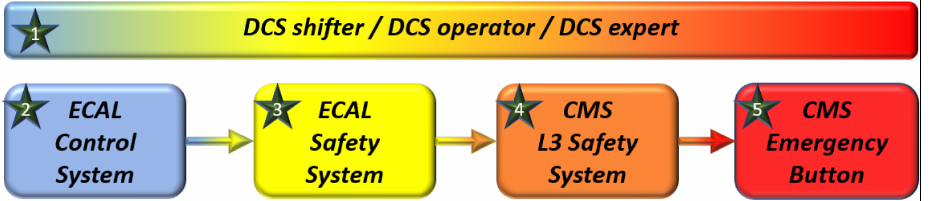
Figure 4. The CMS ECAL 5-layer protection